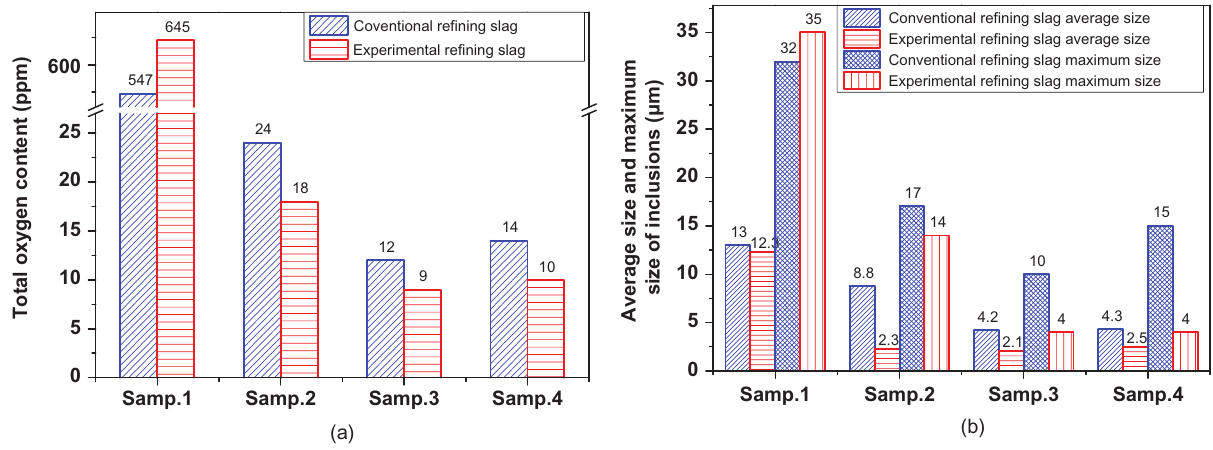
Figure 3: Influence of refining slag on cleanliness variation during refining process: (a) total oxygen and (b) inclusion size.